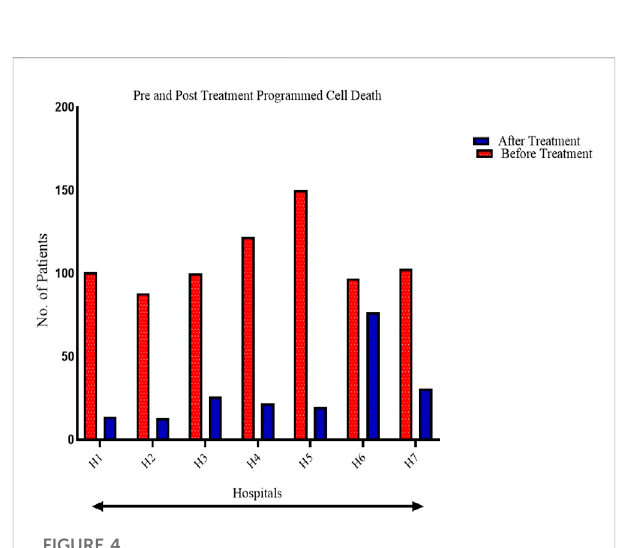
FIGURE 3 A comparison of the effects of Dexmedetomidine on oxidative stress before and after treatment, indicating the potency and clinical signi fi cance of the medication in primary liver cancer.